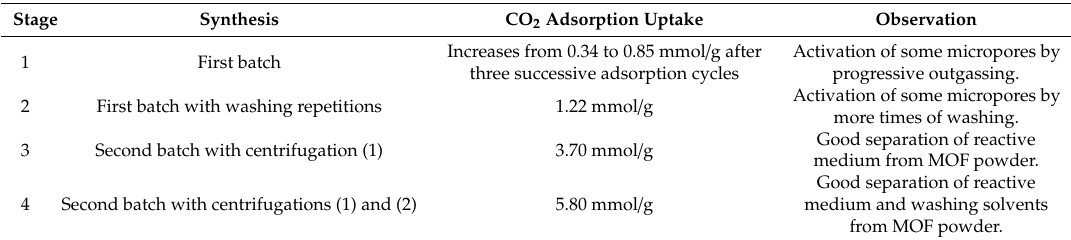
Table 2. Stages of optimization of washing processes in solvothermal